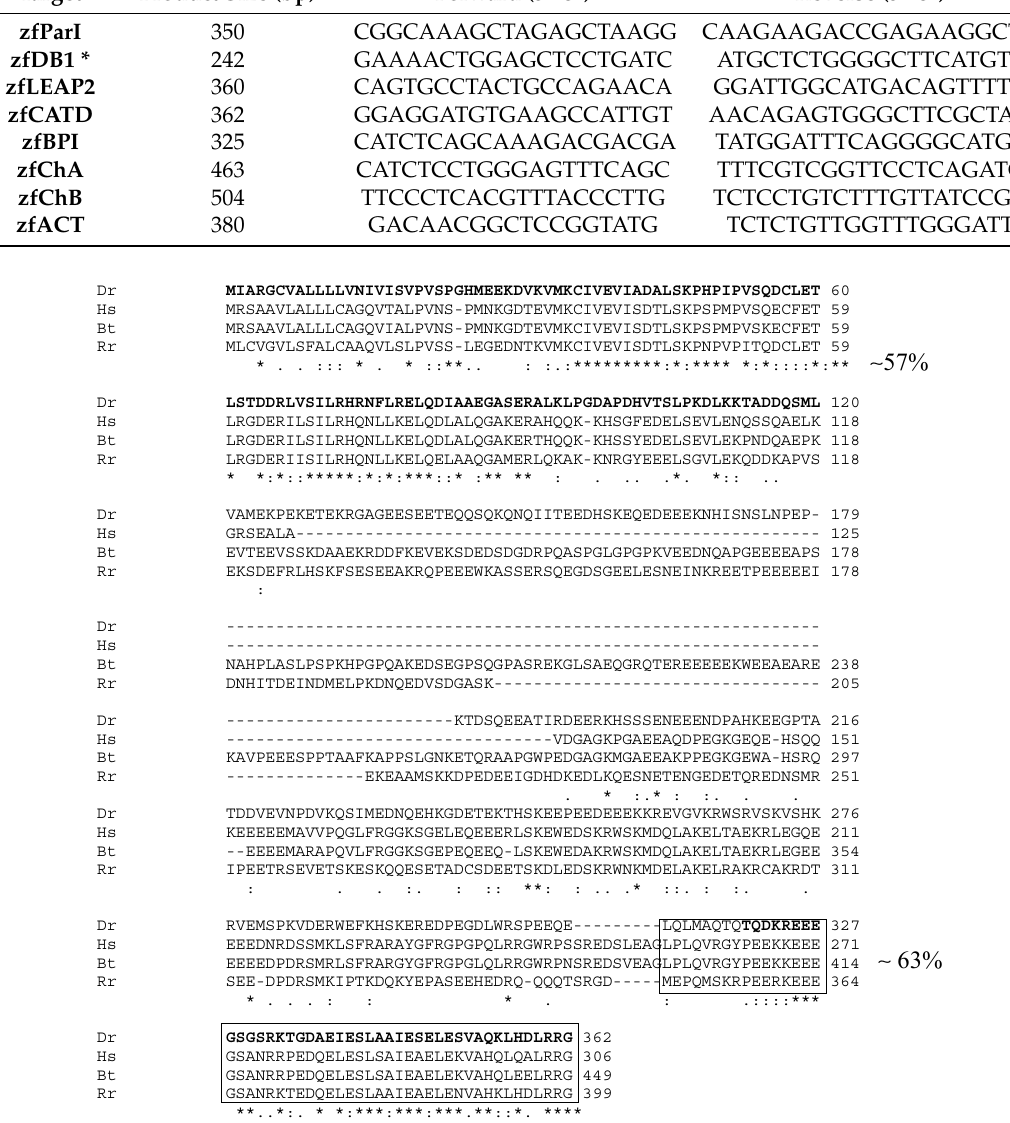
Figure 1. Amino acid sequence alignment of Danio rerio ChromograninA (Dr, drCgA) with CgA from Homo sapiens (Hs) Bos taurus (Bt) and Rana ridibunda (Rr) The boxes indicate the N- and C-termini of drCgA protein, who share higher similarity with the reported sequences.